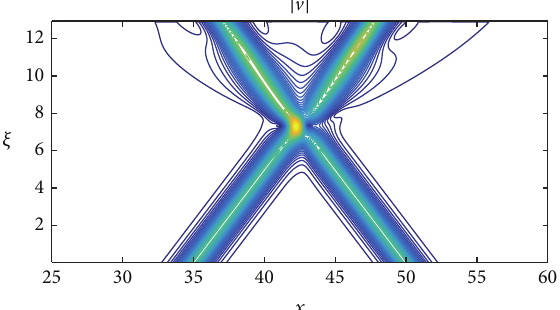
Figure 18: Contour plot of the collision of solitons in Figure